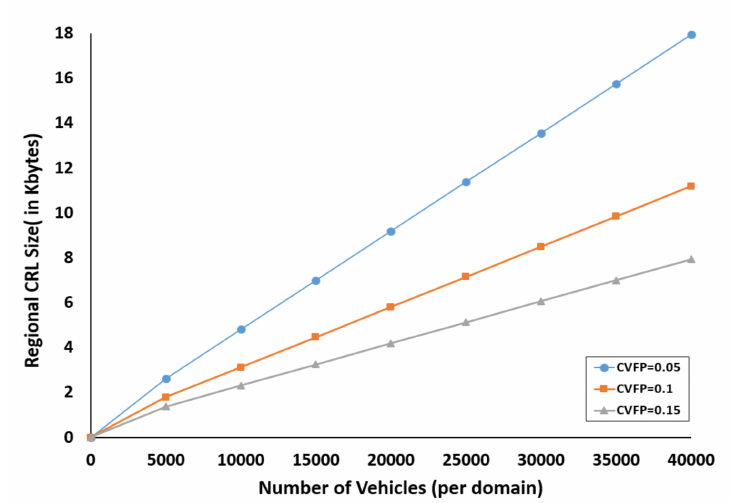
Figure 7. Regional CRL size with the domain